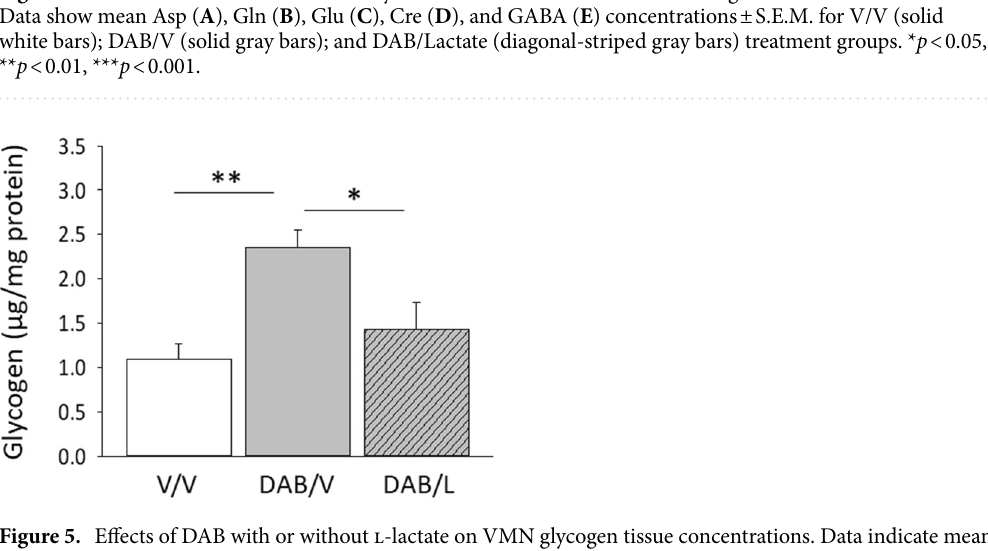
Figure 5. Effects of DAB with or without l-lactate on VMN glycogen tissue concentrations. Data indicate mean VMN tissue glycogen + S.E.M. for the following treatment groups: V/V (solid white bars); DAB/V (solid gray bars); DAB/lactate (diagonal-striped gray bars). * p < 0.05, ** p <